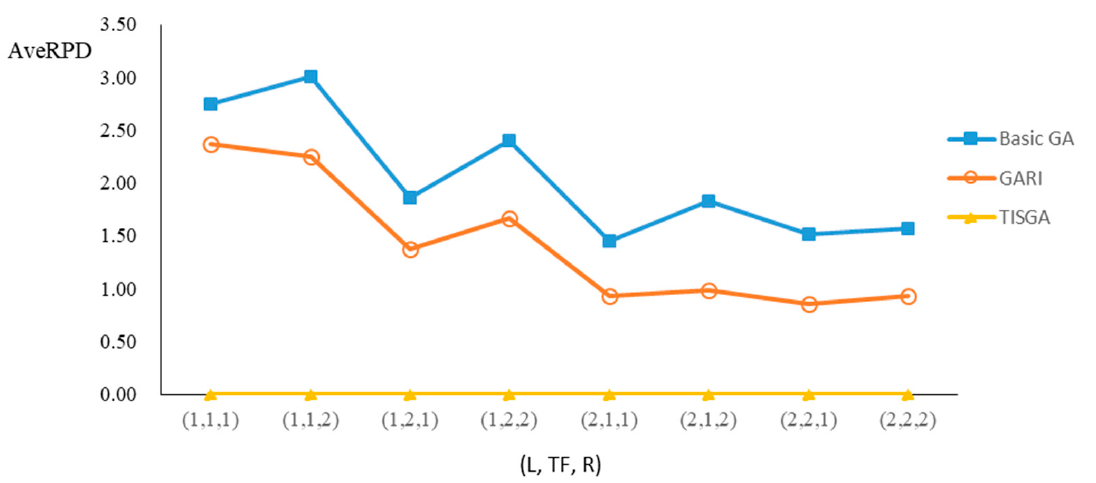
Figure 18. Comparison results for n = 90 with eight combinations of (L, TF, R).